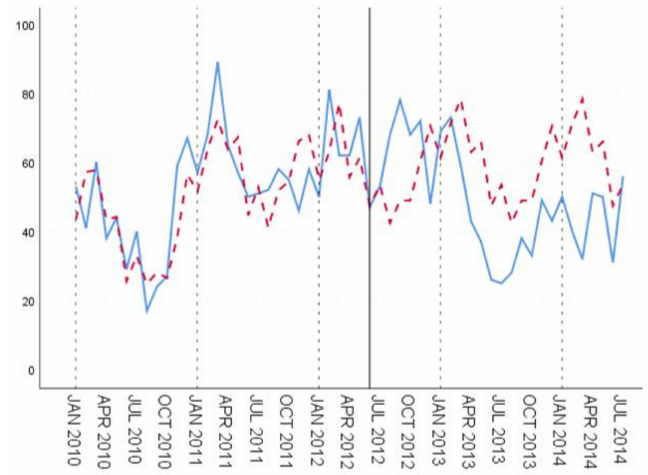
Figure 12. Fitting and prediction results for the time series model, group 1.